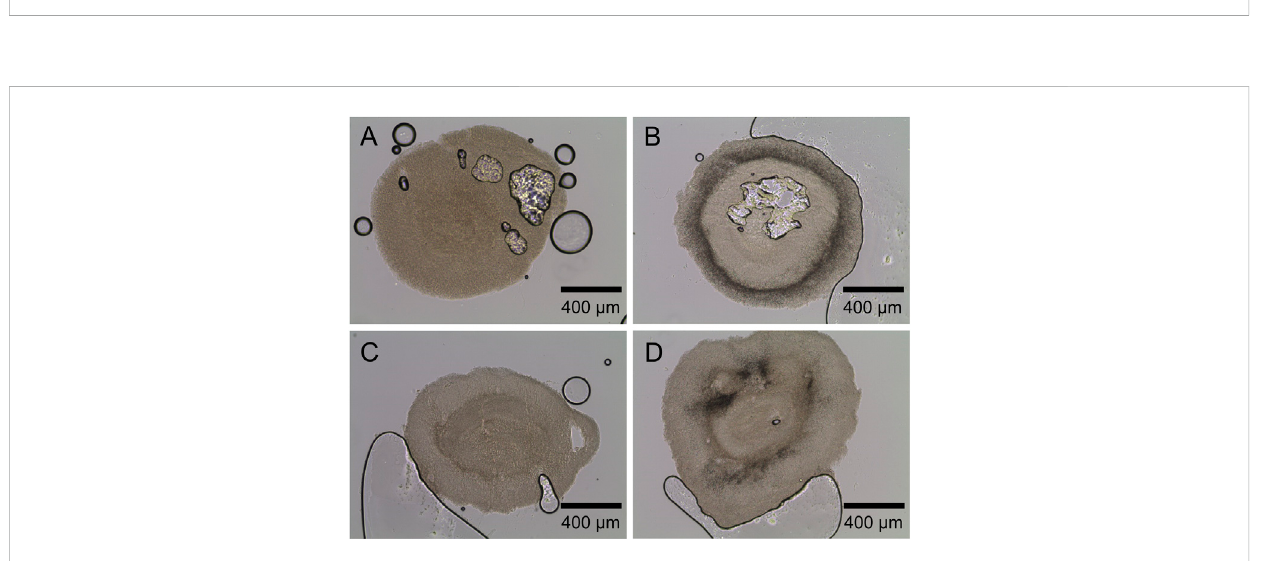
FIGURE 10 Exemplary microscopic images of sliced pellets from (A) unsupplemented control culture. (B) MPEC supplemented with glass microparticles (10 g · L − 1 , x 50 = 7.9 µm). (C) Soylecithin-supplementedculture (SL-IP,7.5 g · L − 1 ). (D) MPEC supplemented with glass microparticles (10 g · L − 1 , x 50 = 7.9 µm) combined with soy lecithin addition (SL-IP, 7.5 g · L − 1